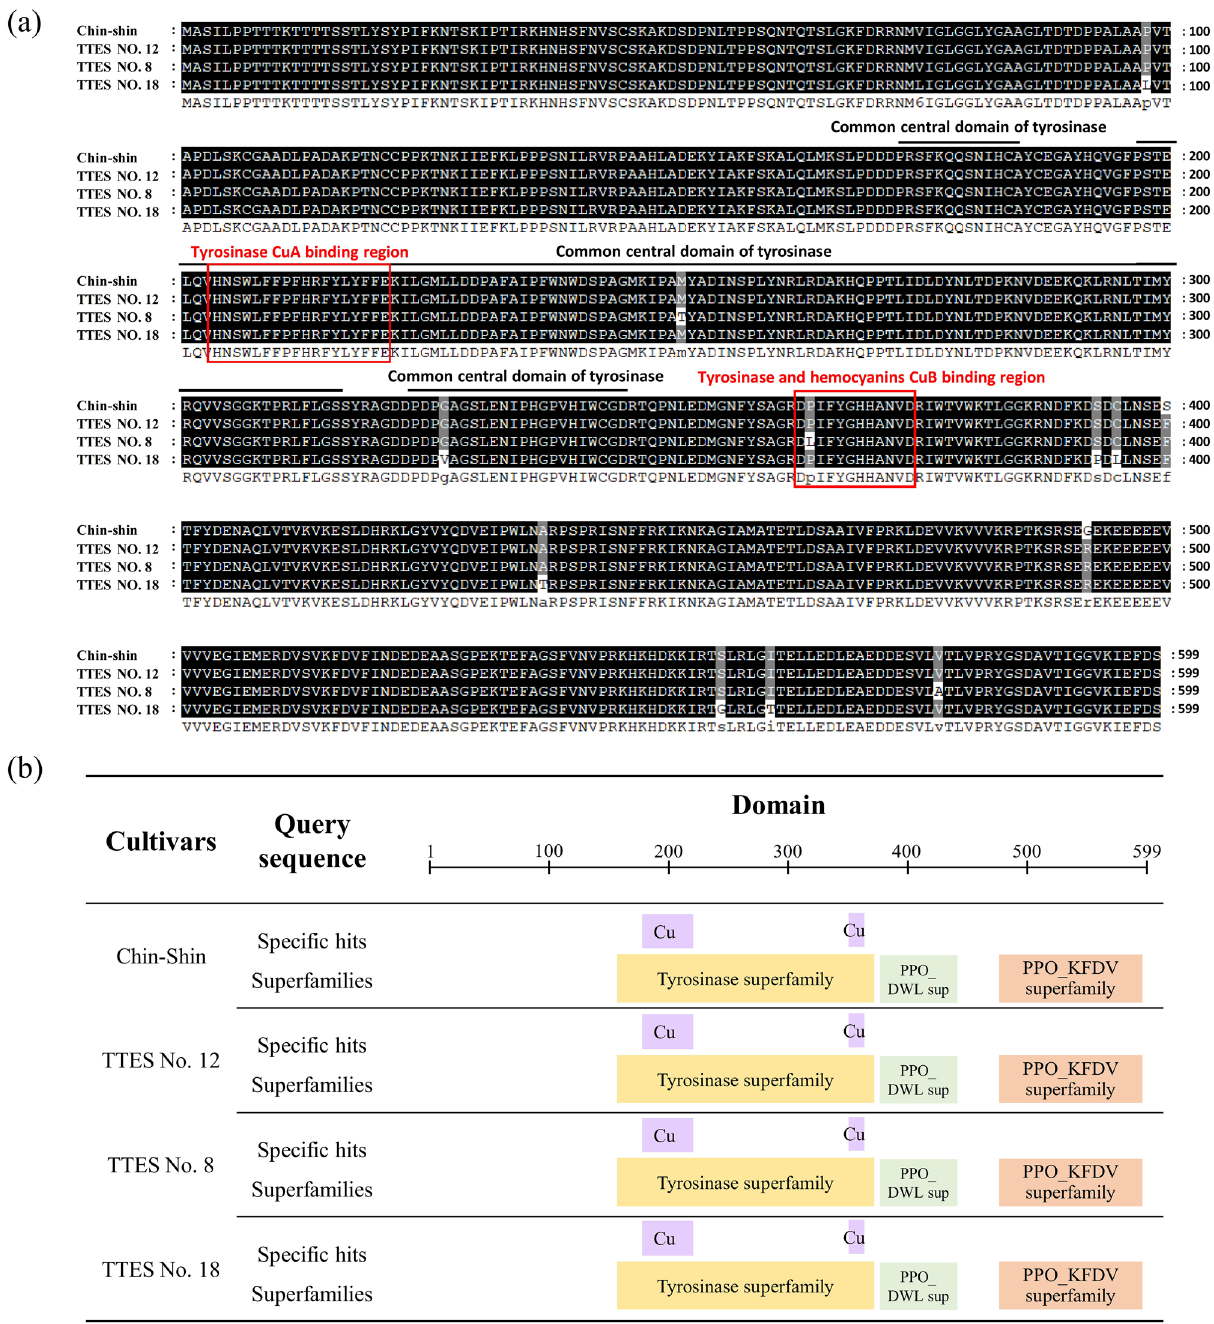
Figure 1. Sequence alignment and functional domain prediction of CsPPO sequences in different cultivars. ( a ) Alignment of amino acid sequences of CsPPO in small- and large-leaf varieties. Black and gray shades indicate sequence conservations of 100% and > 80%, respectively. Sequences were aligned using the ClustalW algorithm. Black lines above the sequences indicate the common central domain of tyrosinase. Red boxes indicate the tyrosinase CuA-binding region HNSWLFFPFHRFYLYFFE and the tyrosinase and hemocyanin CuB-binding region DPIFYGHHANVD. ( b ) Predicted functional domains on the CsPPO sequences. Squares in different color indicate the position of conserved domain of protein families on the sequences. Purple squares represented two cooper ion binding regions of